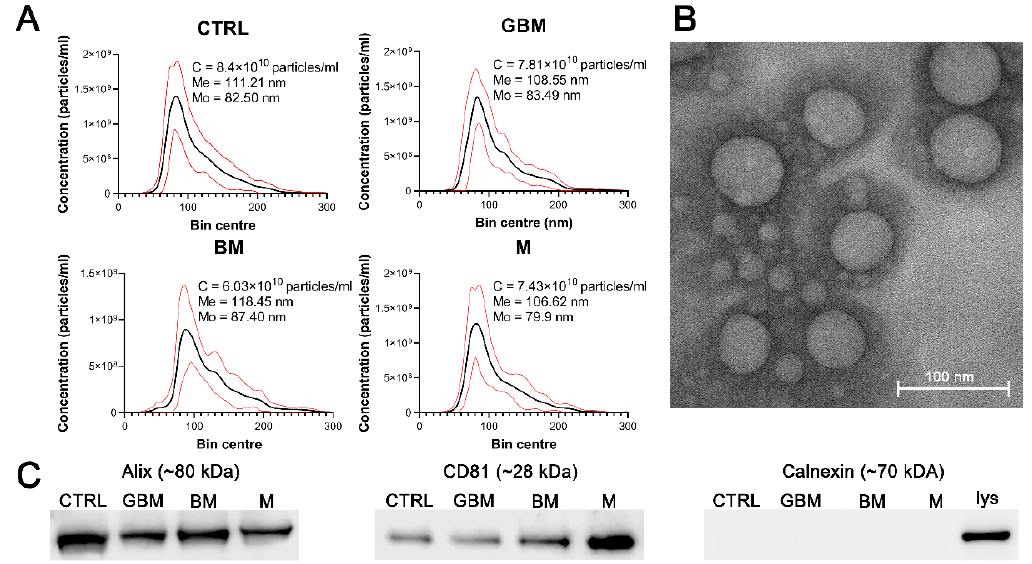
Figure 1 . Characterization of the particles. The figure represents the results of the particle characterization: size distribution of the sEV samples isolated from the four patient groups (black and red lines represent the mean and the standard deviation of the concentration, respectively) ( A ), a representative TEM image of the sEVs ( B ), and the Western blot analysis of the sEV markers ( C ). (Abbreviations: CTRL, control; GBM, glioblastoma multiforme; BM, brain metastasis; M, meningioma; C, particle concentration; lys, cell lysate; Me, mean diameter size; Mo, mode diameter size.)